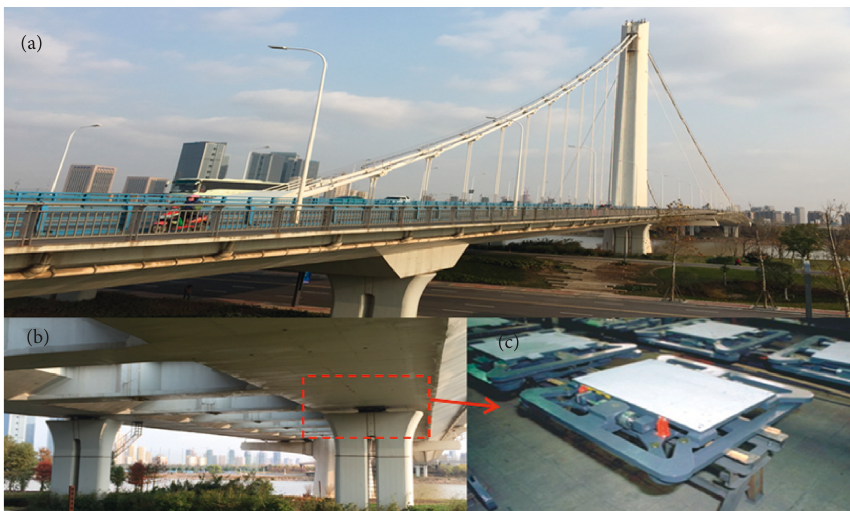
Figure 2: The investigated suspension bridge. (a) Side view. (b) Bottom of the girder. (c) E-type elastic-plastic damping